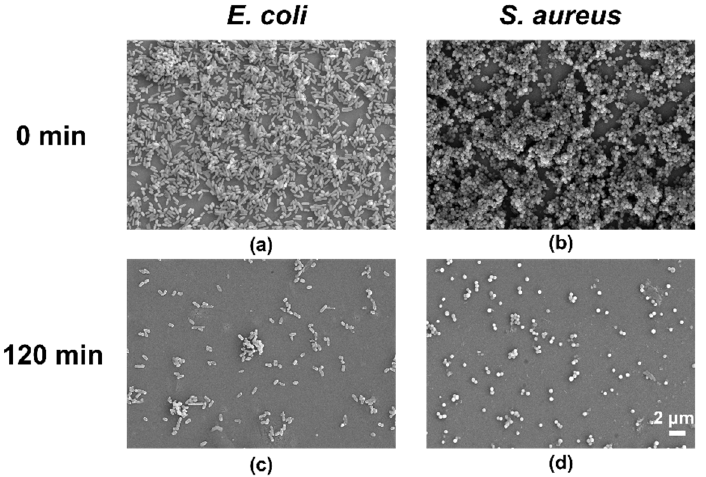
Figure 5. FE-SEM images of E. coli ( a ) and S. aureus ( b ) cultivated for 24 h. ( c , d ) Images after treatment with hydrogel ELID ( n = 3).